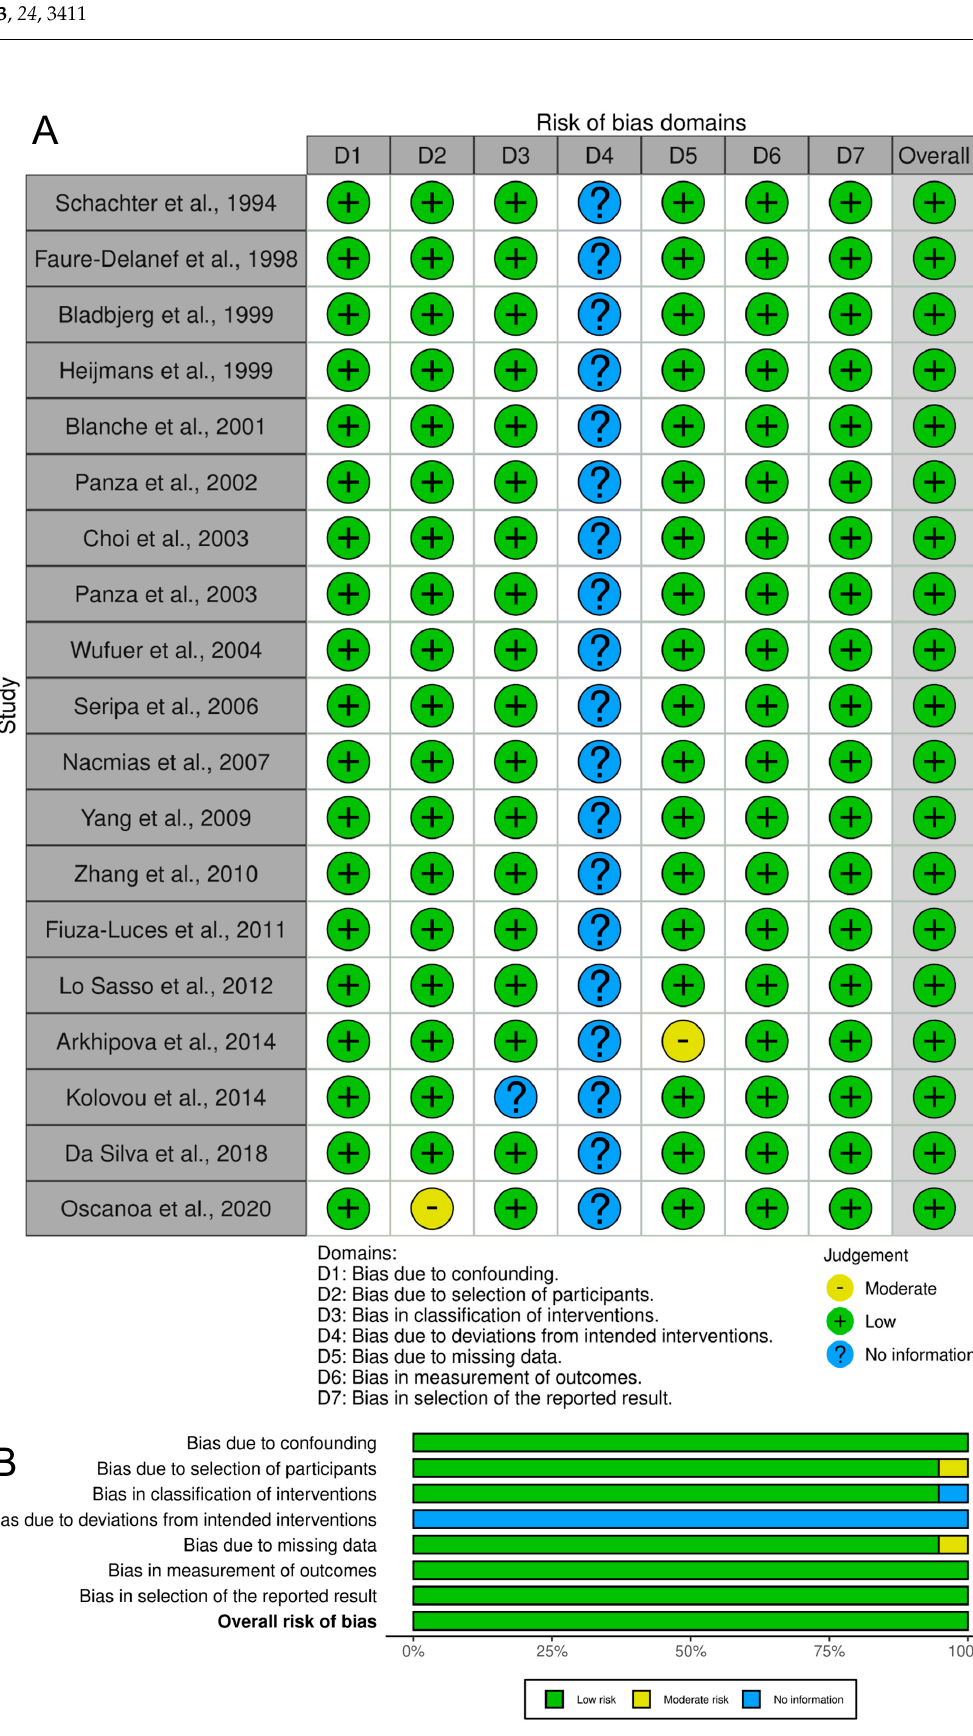
Figure 8. Risk assessment of the studies. ( A ) Traffic light plot showing the assessment of the risk of bias using ROBINS-1. ( B ) Summary plot showing the assessment of the risk of bias using ROBINS-1.